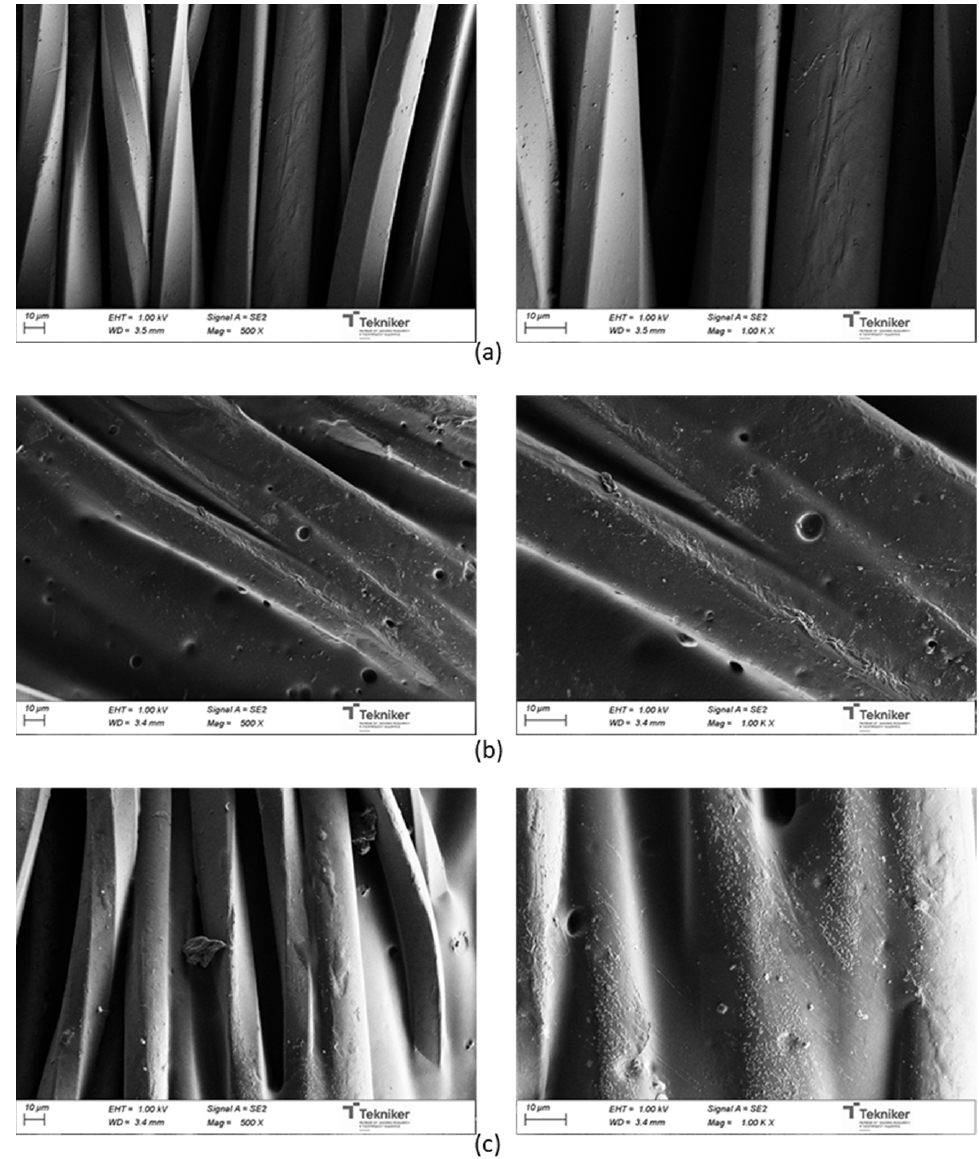
Figure 18. SEM micrographs for: ( a ) untreated UPRON and fabrics coated with ( b ) 3238-3PDO and ( c ) 3238-3POSS.